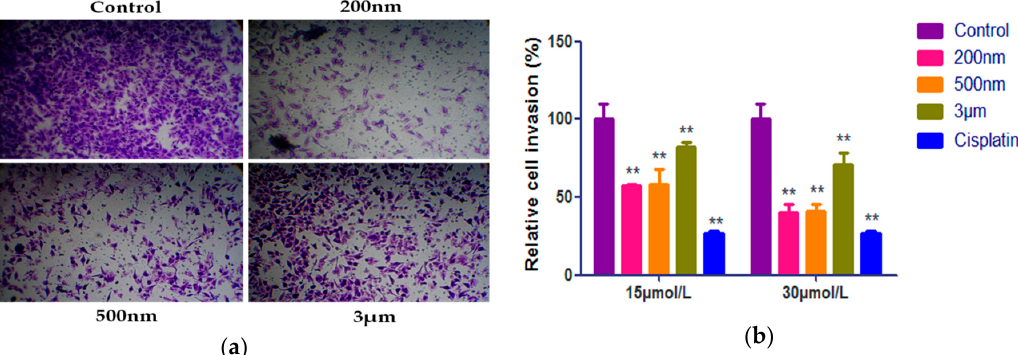
Figure 5. Effects of different sizes and concentrations of QE-NCs on the invasion ability of A549 cells ( n = 3). ( a ) Results of the transwell chamber invasion assay. ( b ) Statistical analysis of the results of the transwell chamber invasion assay. ** p < 0.01, compared with the blank control group. Table 5. The invasion of QE-NCs of different particle sizes on A549 cells ( n = 3). Concentrations